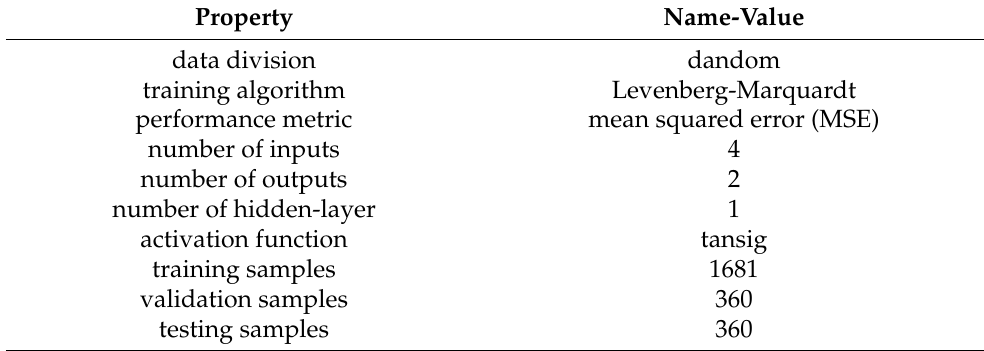
Figure 18. Comparisons of average Nu and pressure coefficient variation with MaF strength ( a , b ) and permeability of PL ( c , d ) obtained with CFD and NNs. Table 2. NN model